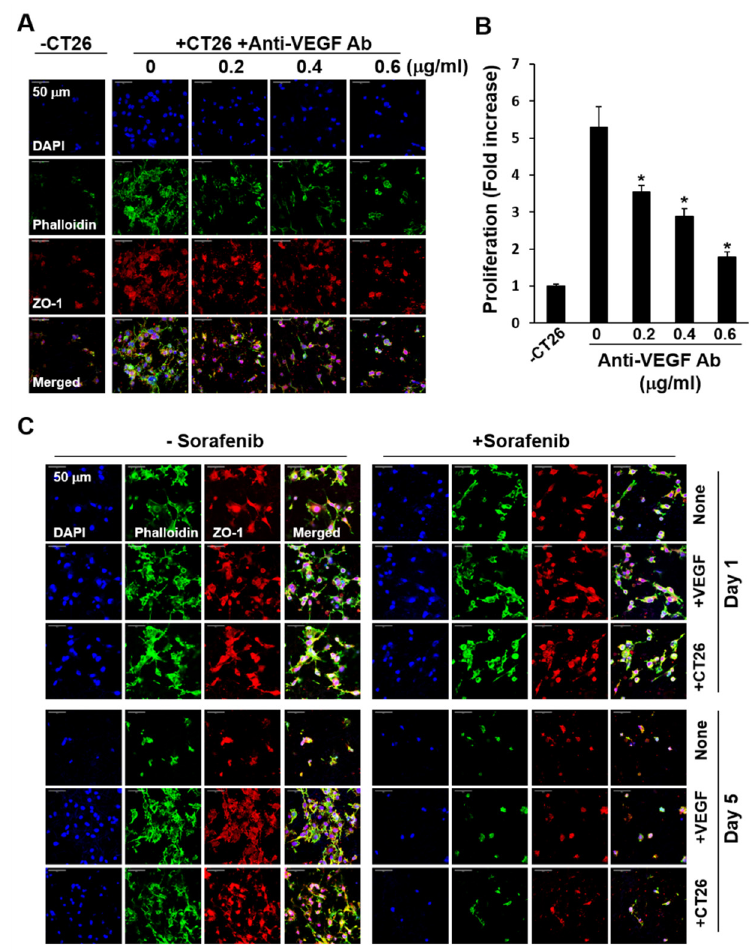
Figure 8. Inhibition of co-culture-induced growth of bEND.3 ECs by anti-VEGF antibody and sorafenib in a two-layer system. bEND.3 and CT26 cells (3 × 10 4 ) were co-cultured in a two-layer system with anti-VEGF antibody at increasing concentrations for 5 d ( n = 3). ( A ) bEND.3 cells on C / DMF-PCL-M in the upper layer were stained with DAPI, phalloidin, and anti-ZO-1 antibodies. Cell morphology was analyzed via confocal microscopy. ( B ) The proliferation of bEND.3 cells was assessed using the CCK-8 assay and presented as a fold increase. ( C ) bEND.3 cells were cultured alone (None), cultured with VEGF ( + VEGF), and co-cultured with CT26 cells ( + CT26) in the presence ( + Sorafenib) or absence ( − Sorafenib) of sorafenib (1 µ M) for 1 d and 5 d ( n = 3). Images represent three independent experiments. Data are presented as mean ± SD values ( n = 3). * p < 0.05, compared to cultures without anti-VEGF Ab.